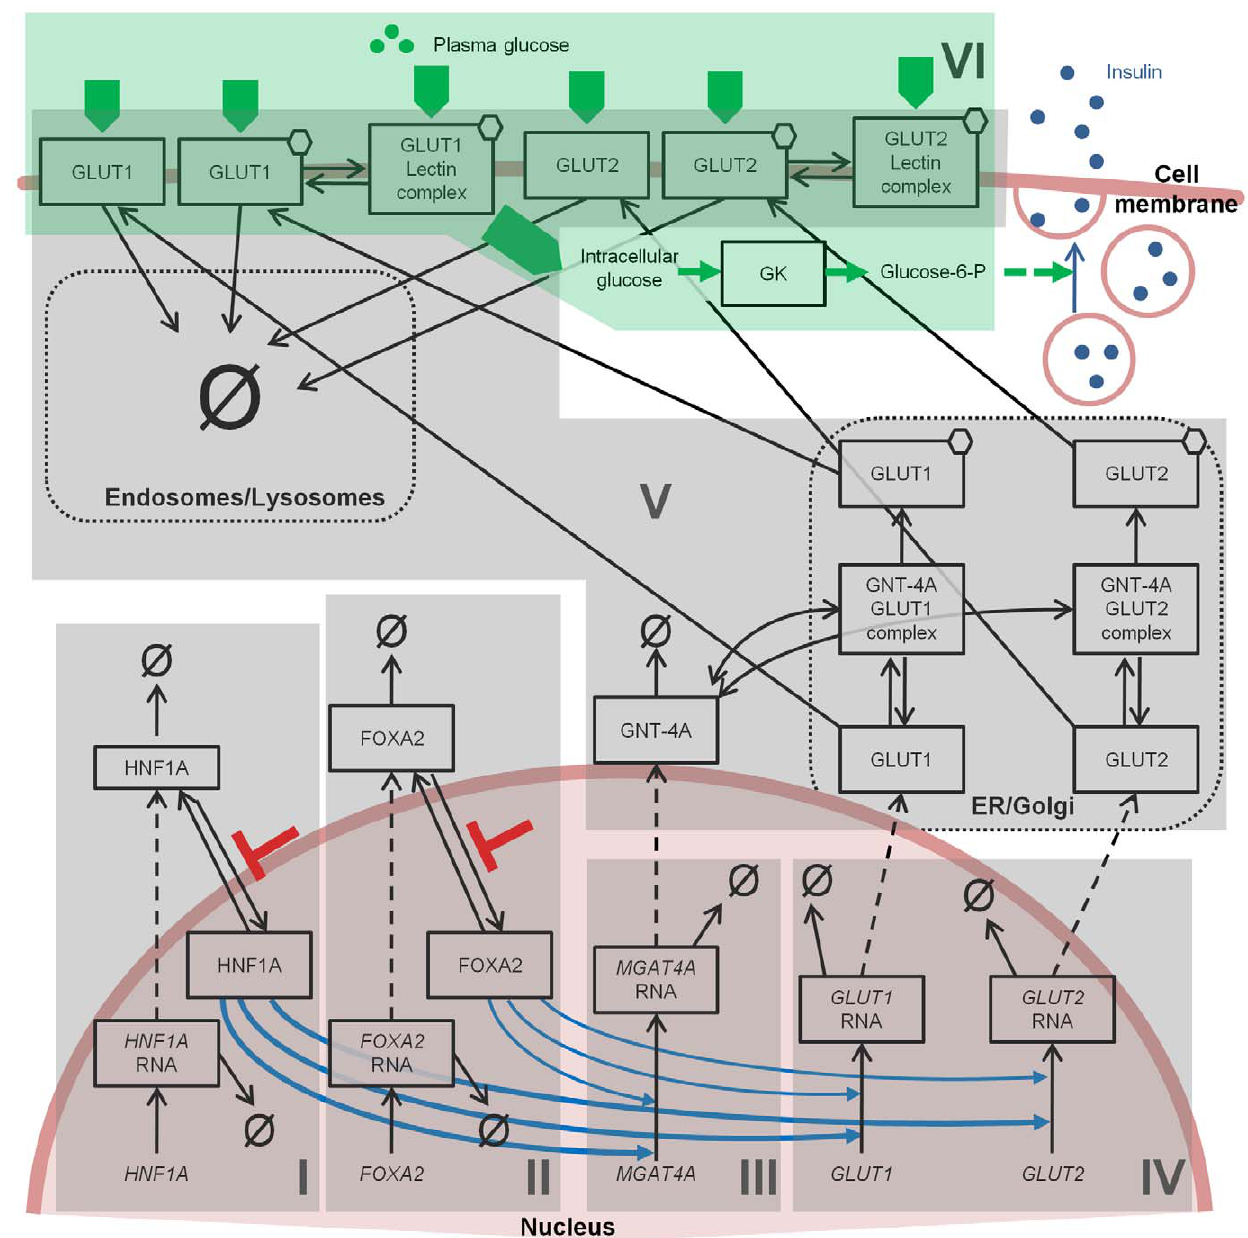
Figure 3. Schematic representation of the processes included in the mathematical model. The six subsystems discussed in the text are highlighted and denoted by roman numbers. Thick blue arrows indicate activation of transcription by promoter binding and histone hyperacetylation, thin blue arrows activation only by promoter binding; red bars indicate an inhibitory effect on nuclear residency of transcription factors. Ø symbol indicates degradation, hexagons the glycosylated forms of the proteins. Green arrows show the path of glucose entrance into the cell, its phosphorylation, and the ultimate activation of insulin secretion.